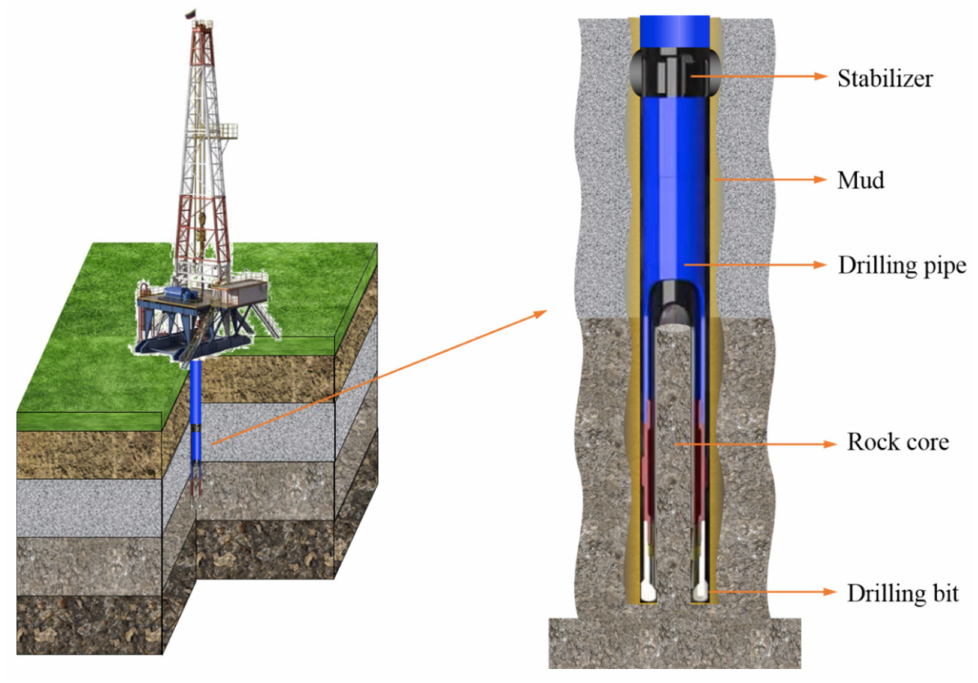
Figure 1. Schematic diagram of core